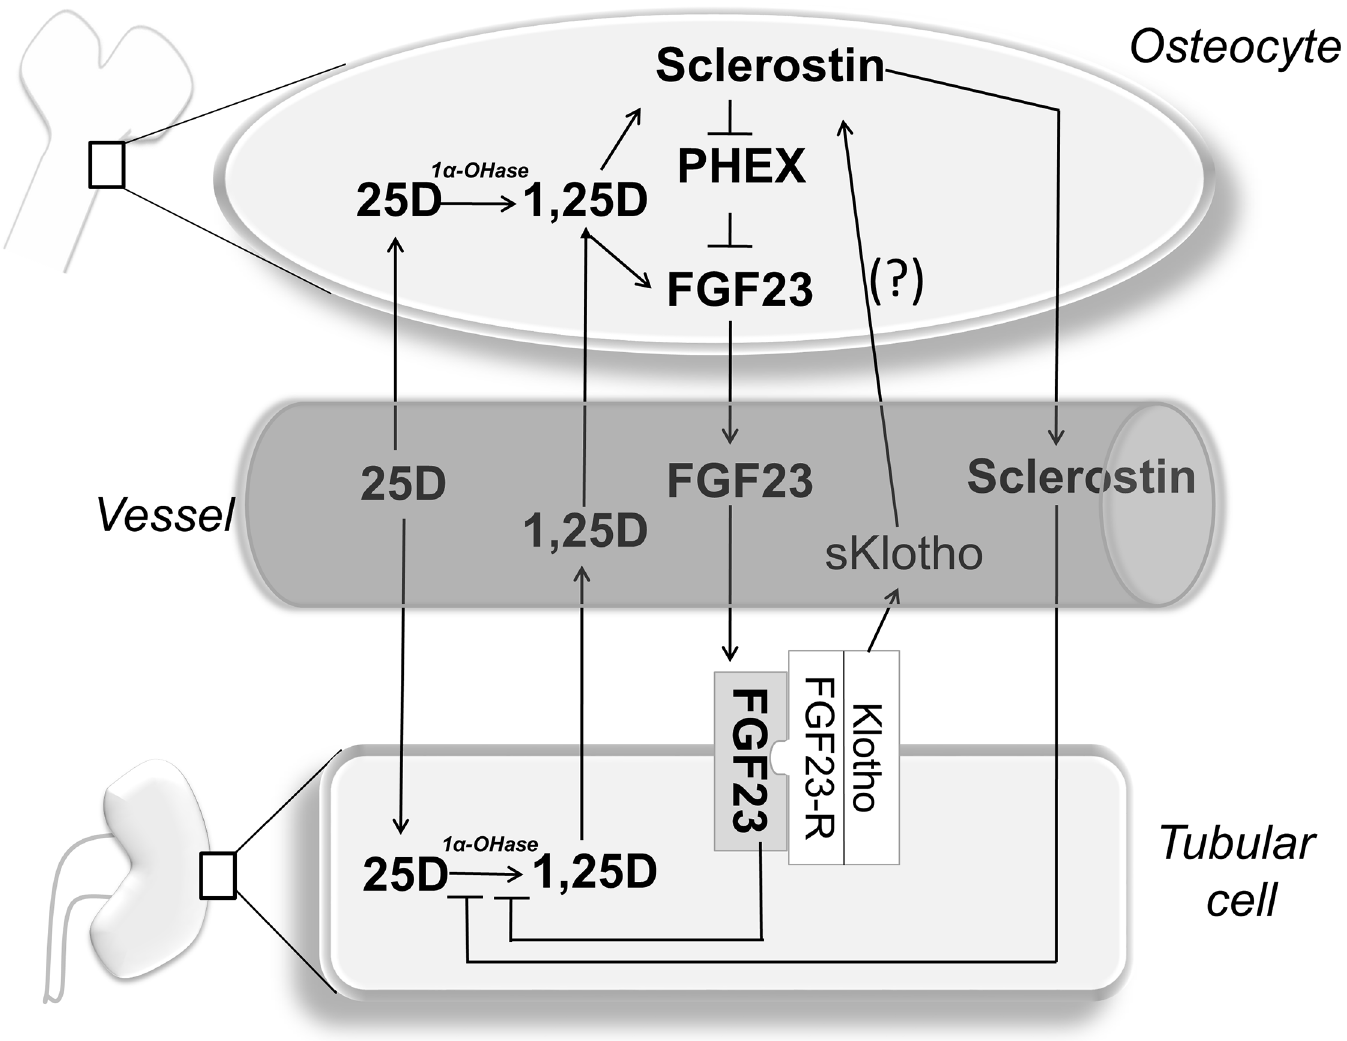
Fig 3. Bone-kidney axis. Schematic of the possiblepathophysiologic links of Sclerostin with FGF23-Klotho and vitamin D system in kidney transplant patients. Intracellular 1,25D stimulates Sclerostin synthesis. Sclerostin, through inhibitionof PHEX (an FGF23 inhibitor),indirectlyincreasesFGF23 production. Also, Sclerostin inhibits1,25D synthesis through direct (inhibitionof renal 1- α OH-ase) and indirect (stimulation of FGF23) effects. S-Klotho could be another positive local modulator of Sclerostin synthesis. Abbreviations: PHEX, a protein encodedby the phosphateregulatinggenewith homologies to endopeptidaseson the X chromosome; FGF23, Fibroblast growth factor 23; 1 α OH-ase, 1alpha-hydroxylase;25D, 25-hydroxyvitaminD; 1,25D, 1,25- dihydroxyvitaminD; Arrows: Stimulation; End Lines: Inhibition.